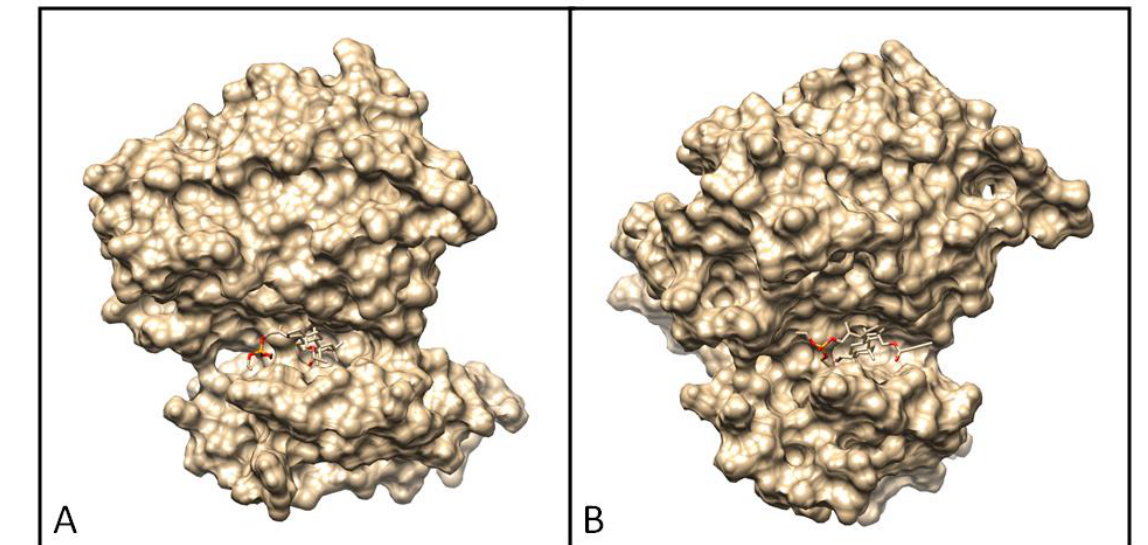
Figure 12. Docking pose of EGFR tyrosine kinase complex with 7a ( A ) and 7b ( B ). The top docked pose of compound 7a in the binding site showed hydrophobic inter- actions with Gly690, Thr830 (carbon hydrogen bond), Phe699 ( π –alkyl), Ala698, Lys721, Cys751, Ala719, Leu820, Val702, and Cys773 (alkyl–alkyl). Moreover, hydroxy groups of triterpene in positions C3 were involved in hydrogen bonds to carboxyl oxygen atom of Thr766 (Figure 13).